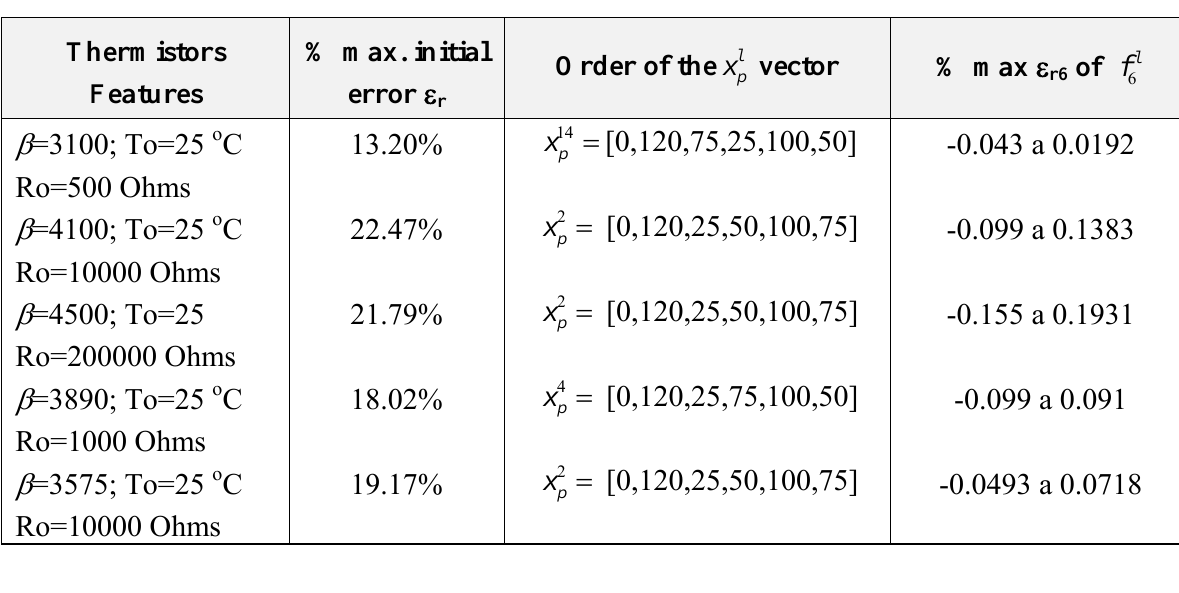
Table 1 . Improved Algorithm evaluation